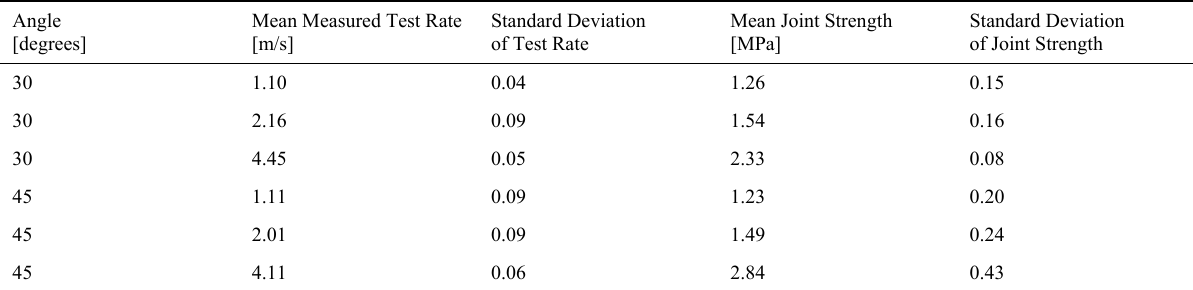
Table 2: Joint strength for a given angle and test rate.